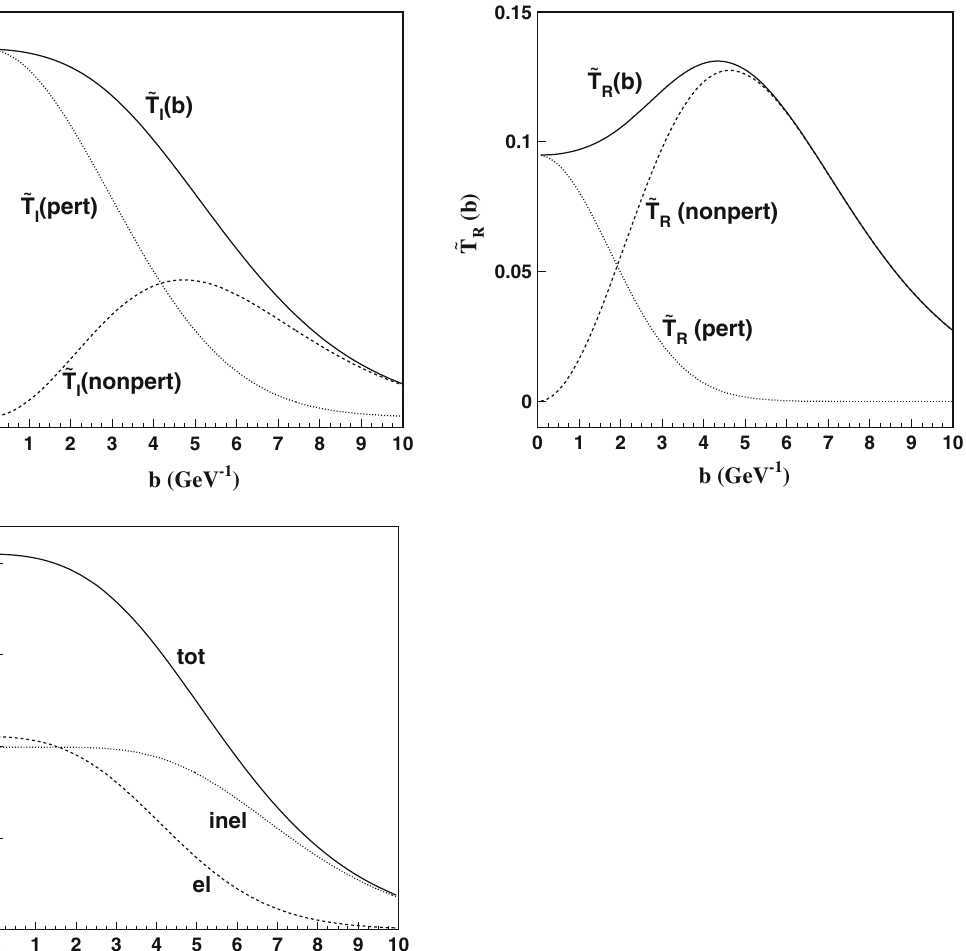
terms dominate the central region of b ≤ 2 GeV − 1 ∼ 0 . 4 fm while the non-perturbative terms are strongly dominating for large b . In c the plots of differential cross sections of Eqs. (21, 22, 23) give hints about the structure of the interaction as observed in the transverse collision